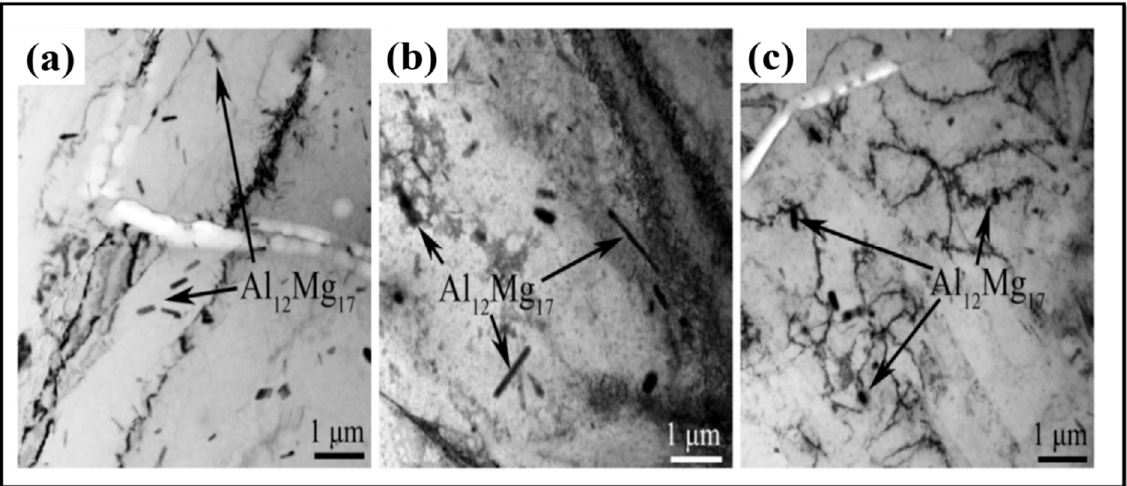
Figure 12. TEM images of precipitations distribution at SZ of AZ31 alloy friction stir processed: ( a ) rotation speed of 1000 rpm—processing speed of 25 mm/min, ( b ) rotation speed of 5000 rpm—processing speed of 125 mm/min, and ( c ) AZ31 alloy unprocessed (Reprinted with permission from ref. [3]. Copyright 2020 Elsevier